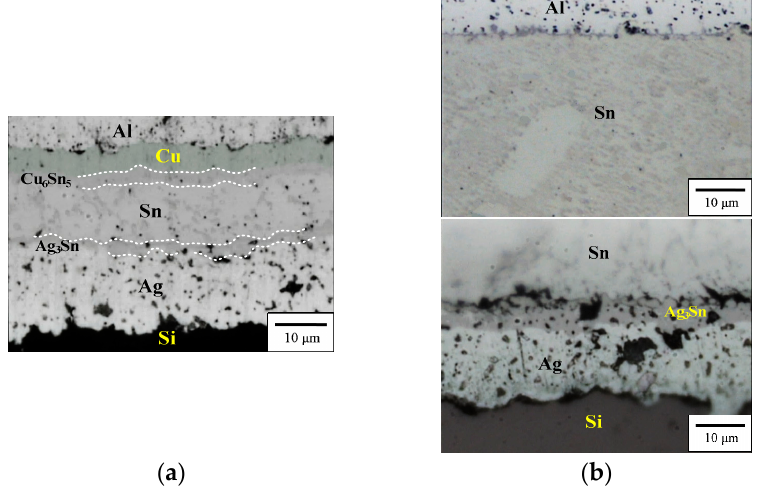
Figure 2. Interfacial images of ( a ) the EP and ( b ) the HD PV modules.